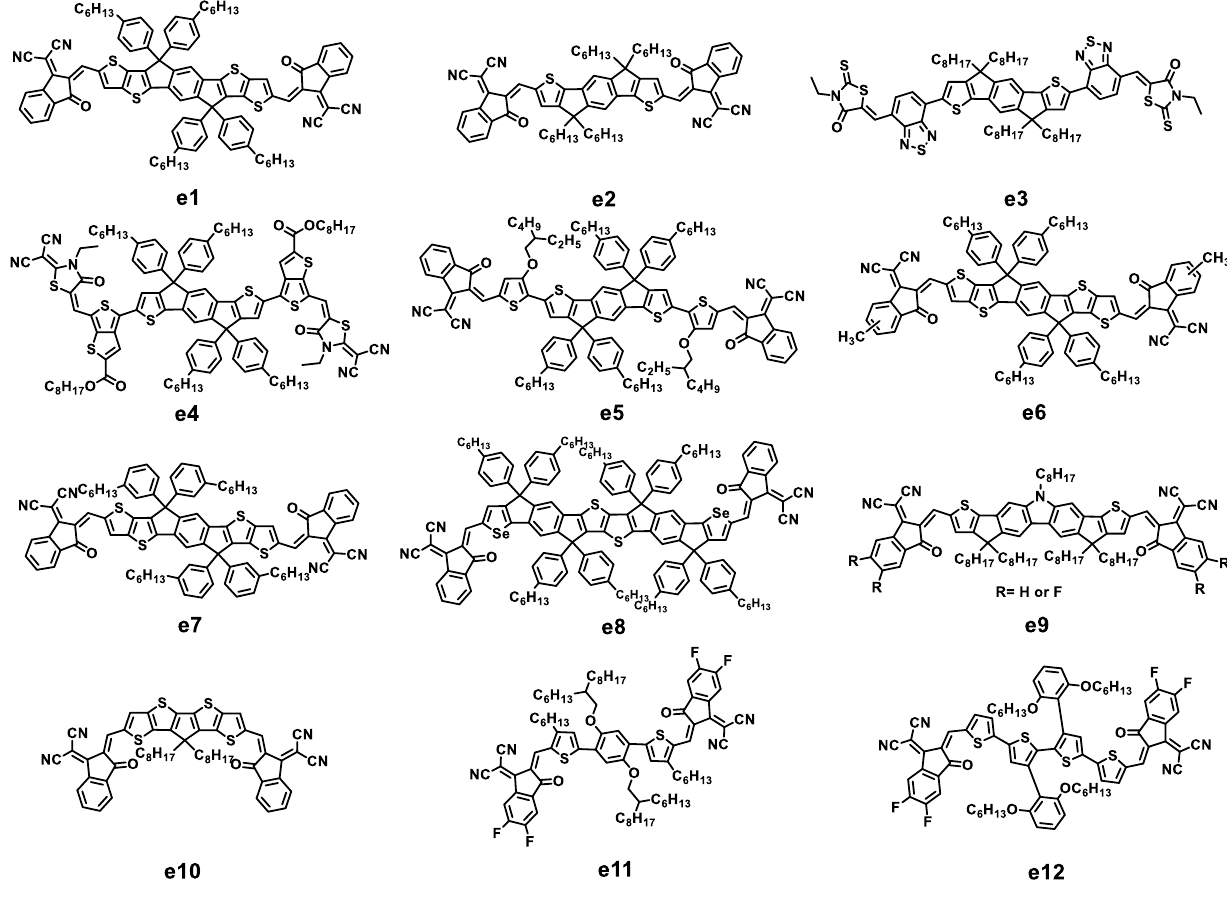
Fig. 5 Chemical structures of A-D-A-type